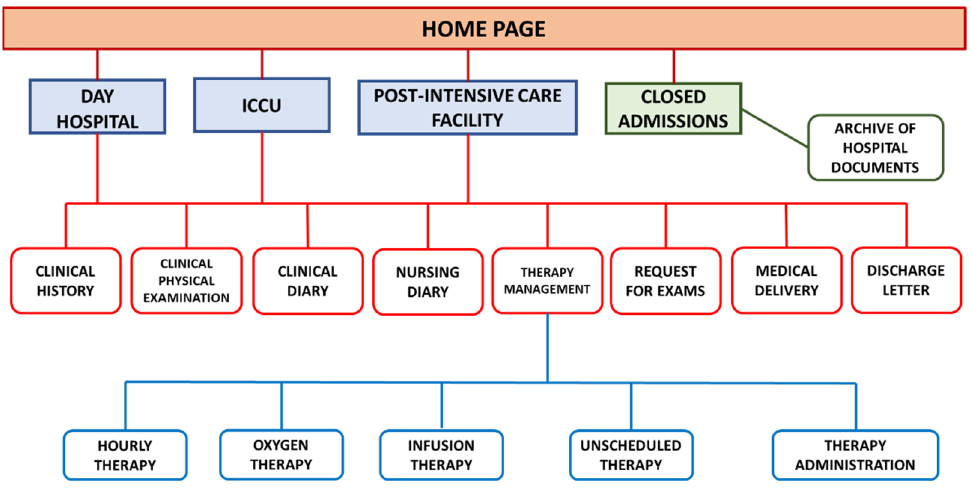
Figure 2. Global scheme of the